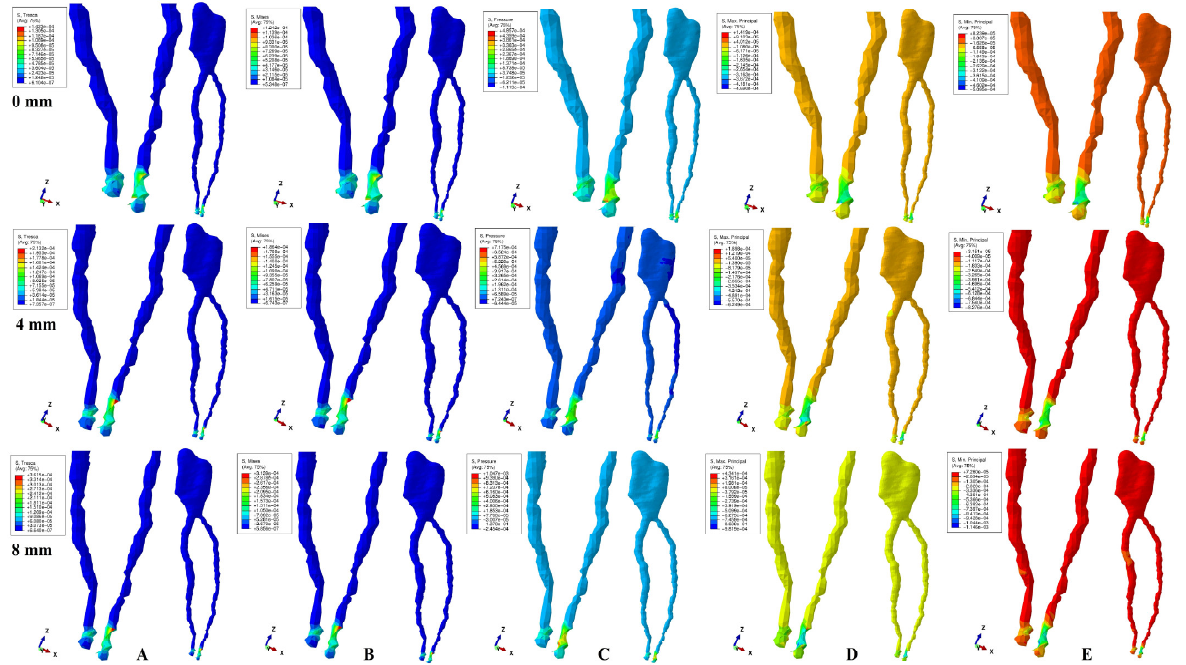
Figure 2. Stress distribution produced by intrusion movement in the apical NVB and dental pulp of one of the nine models (intact, 4 mm and 8 mm reduced periodontium, vestibular-mesial view) in MPa: ( A )—Tresca, ( B )—Von Mises, ( C )—Pressure, ( D )—Maximum principal, ( E )—Minimum principal.